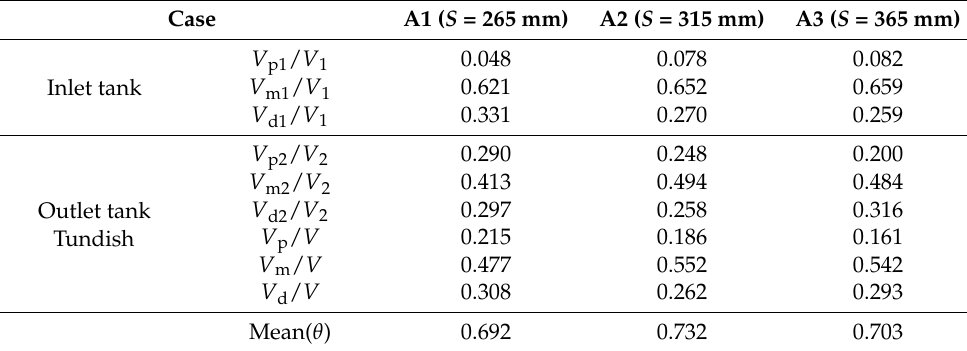
Table 5. The water model experiment results of Cases A1, A2 and